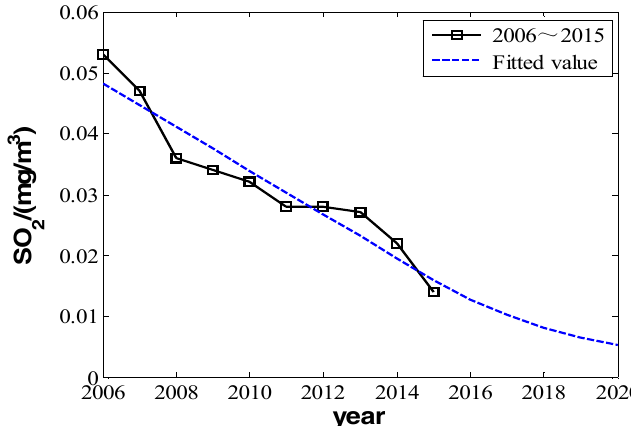
Picture 8. The actual value and predicted value of sulfur dioxide’ annual daily mean in 2006 to 2020.